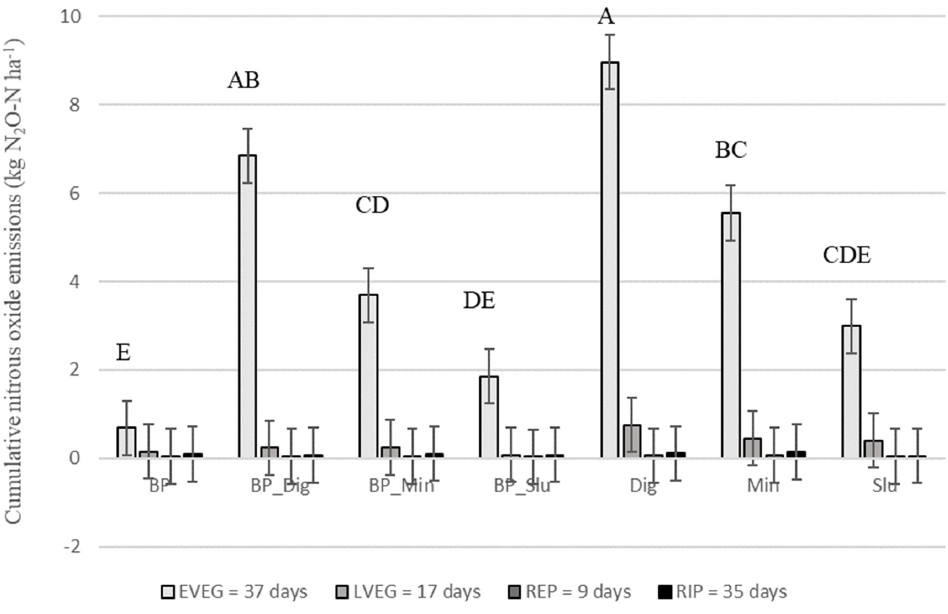
Figure 8. Cumulative nitrous oxide emissions (kg N 2 O–N ha − 1 ) over the cropping season at different phenological stages for the BP-treated plots at the D2 dose, and the corresponding fertilized controls. Different letters refer to significantly different mean values.